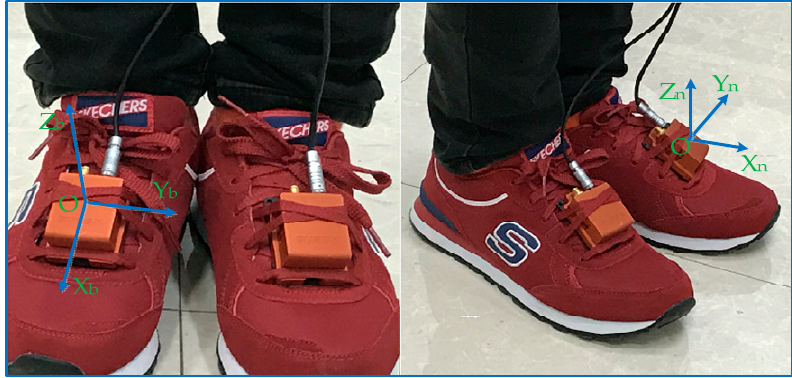
right, and the Z n axis perpendicular to the X n OY n plane, upwards. The coordinates of the navigation subsystem bound to the feet are defined in the same way.